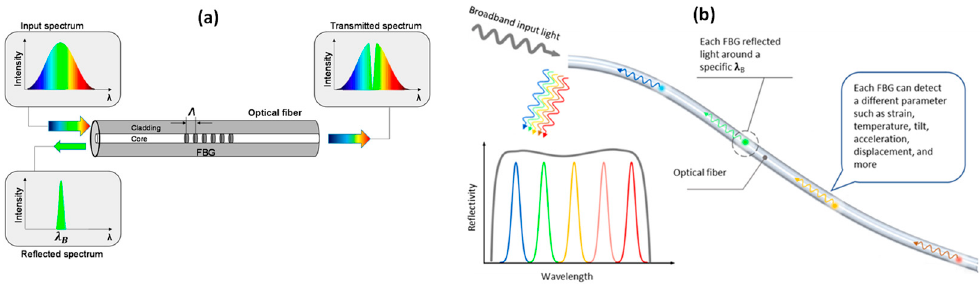
Figure 1. Working principle of fiber Bragg gratings [67,68]: ( a ) schematic of the device and typical reflected and transmitted spectra; and ( b ) schematic of the FBG array in a single fiber by wavelength multiplexing.